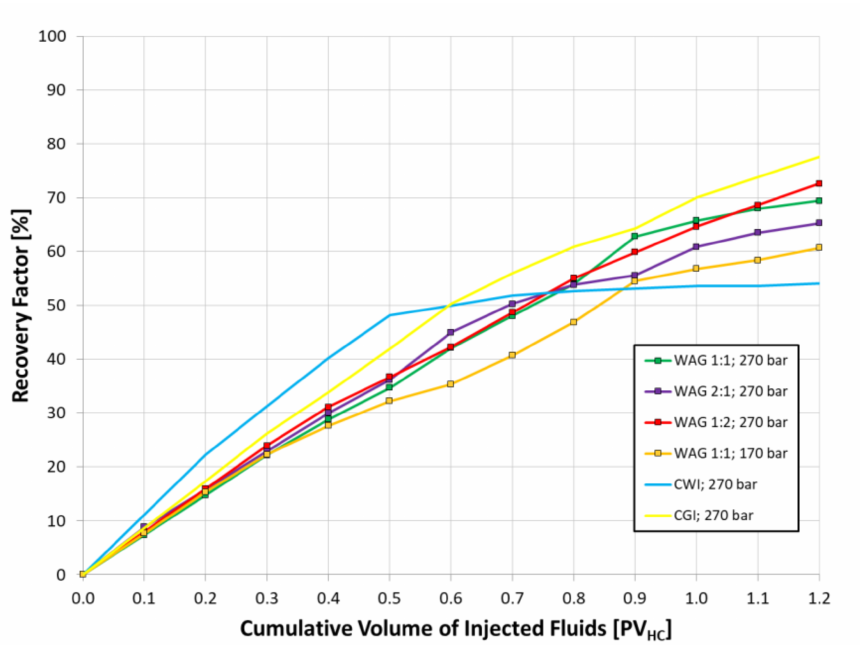
Figure 13. Oil recovery efficiency using AG with different WAG schemes compared to CWI and CGI injection.